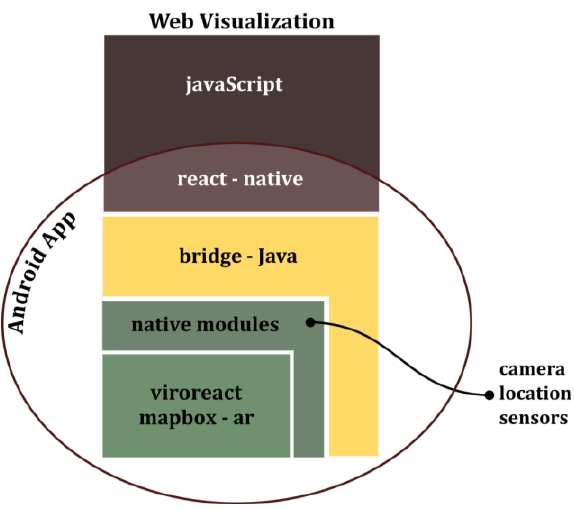
Figure 1. Architecture of the Augmented Reality application